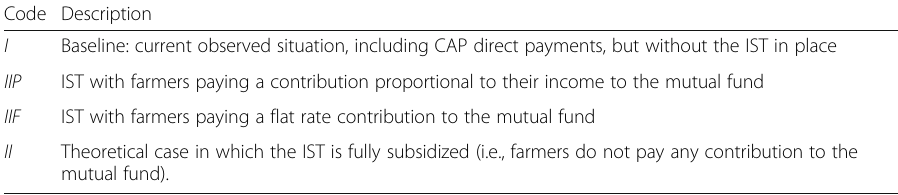
Table 1 Description of the simulation scenarios referring to the implementation of the IST Code